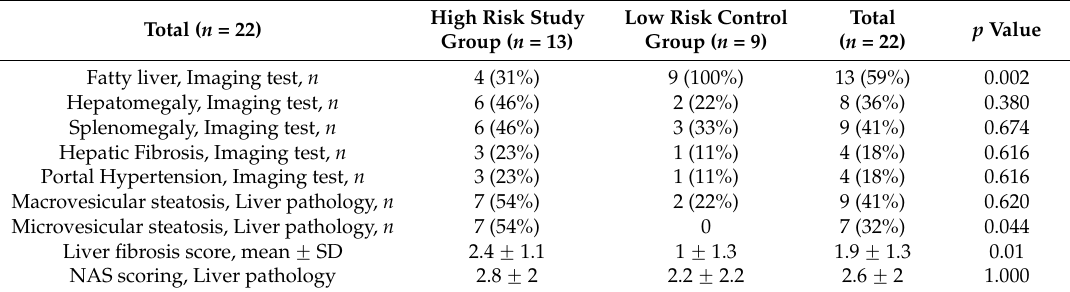
Table 2. Imaging and histologic characterization of